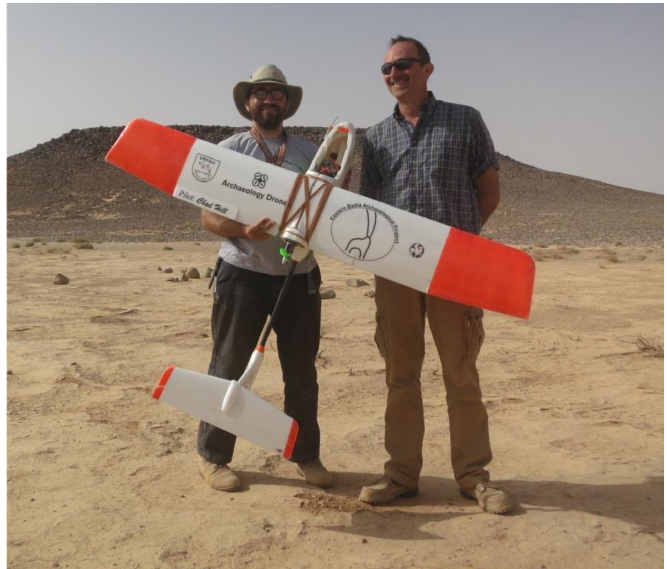
Figure 4. The authors with the fixed-wing drone at Wadi